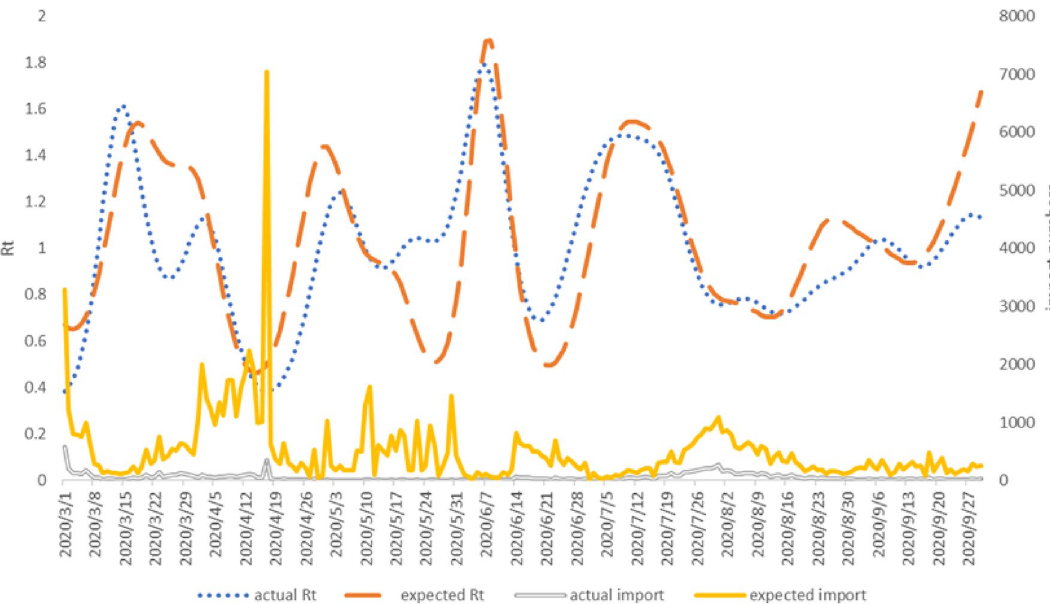
Figure 5. Acutal Rt and expected Rt with actual and expected number of importing cases in